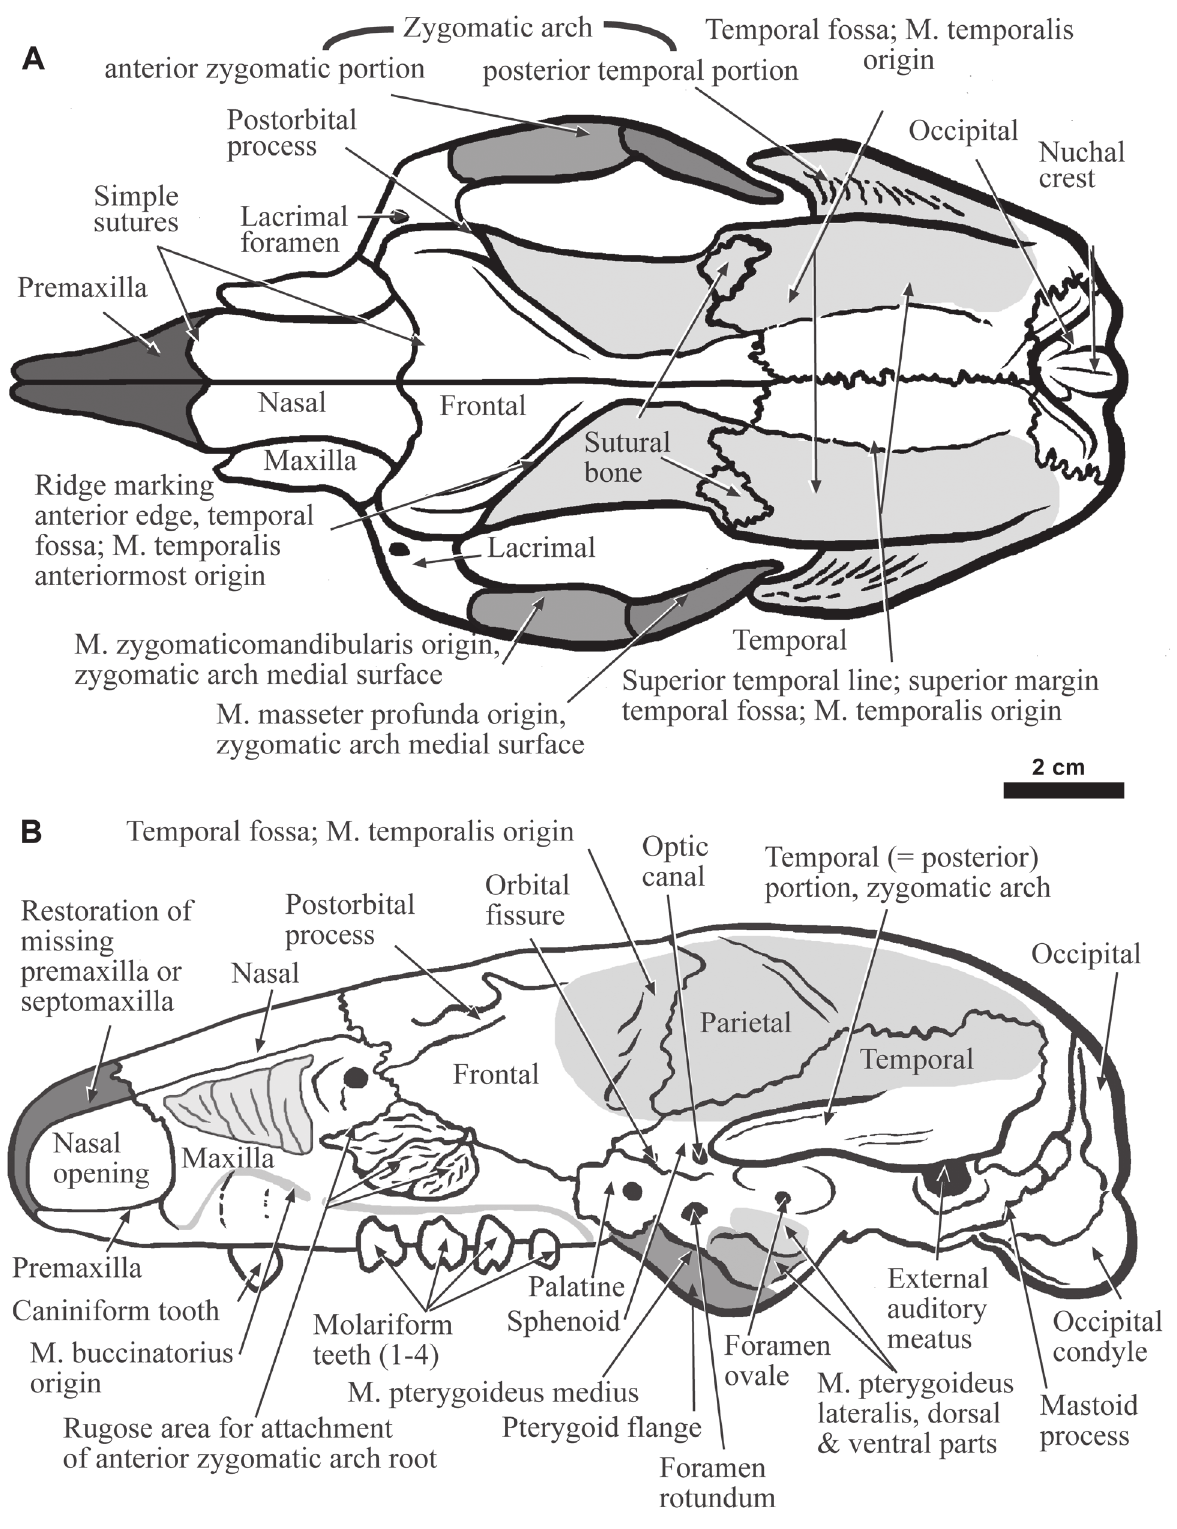
Figure 1. The skull of Hapalops , dorsal view ( A ) and lateral view ( B ), with skeletal and dental features discussed in the text labeled. The scars of muscle origin are shown by shaded areas. The anterior portion of the zygomatic arch has been removed from B to show the rugosity of the articular surface, and to reveal structures on the side of the skull that would otherwise be